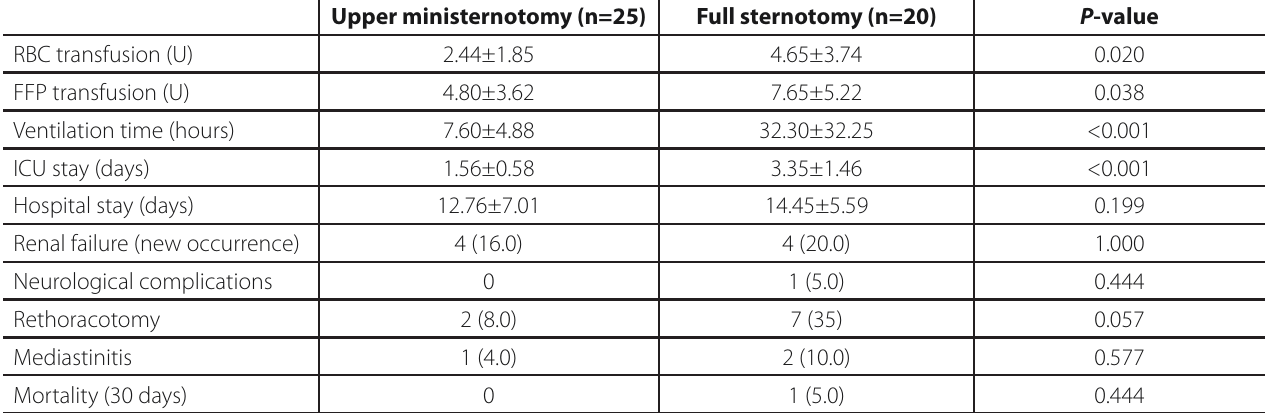
Table 3. Postoperative